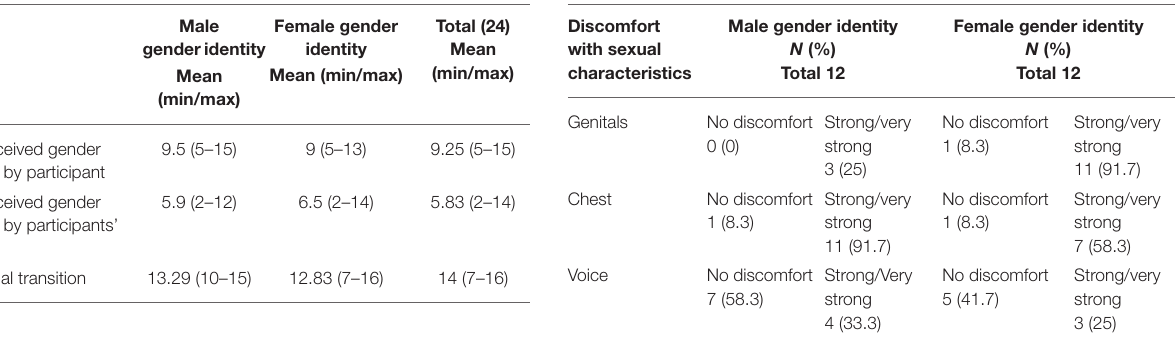
TABLE 2 | Gender perception and social gender transition. TABLE 3 | Level of discomfort with sexual characteristics.